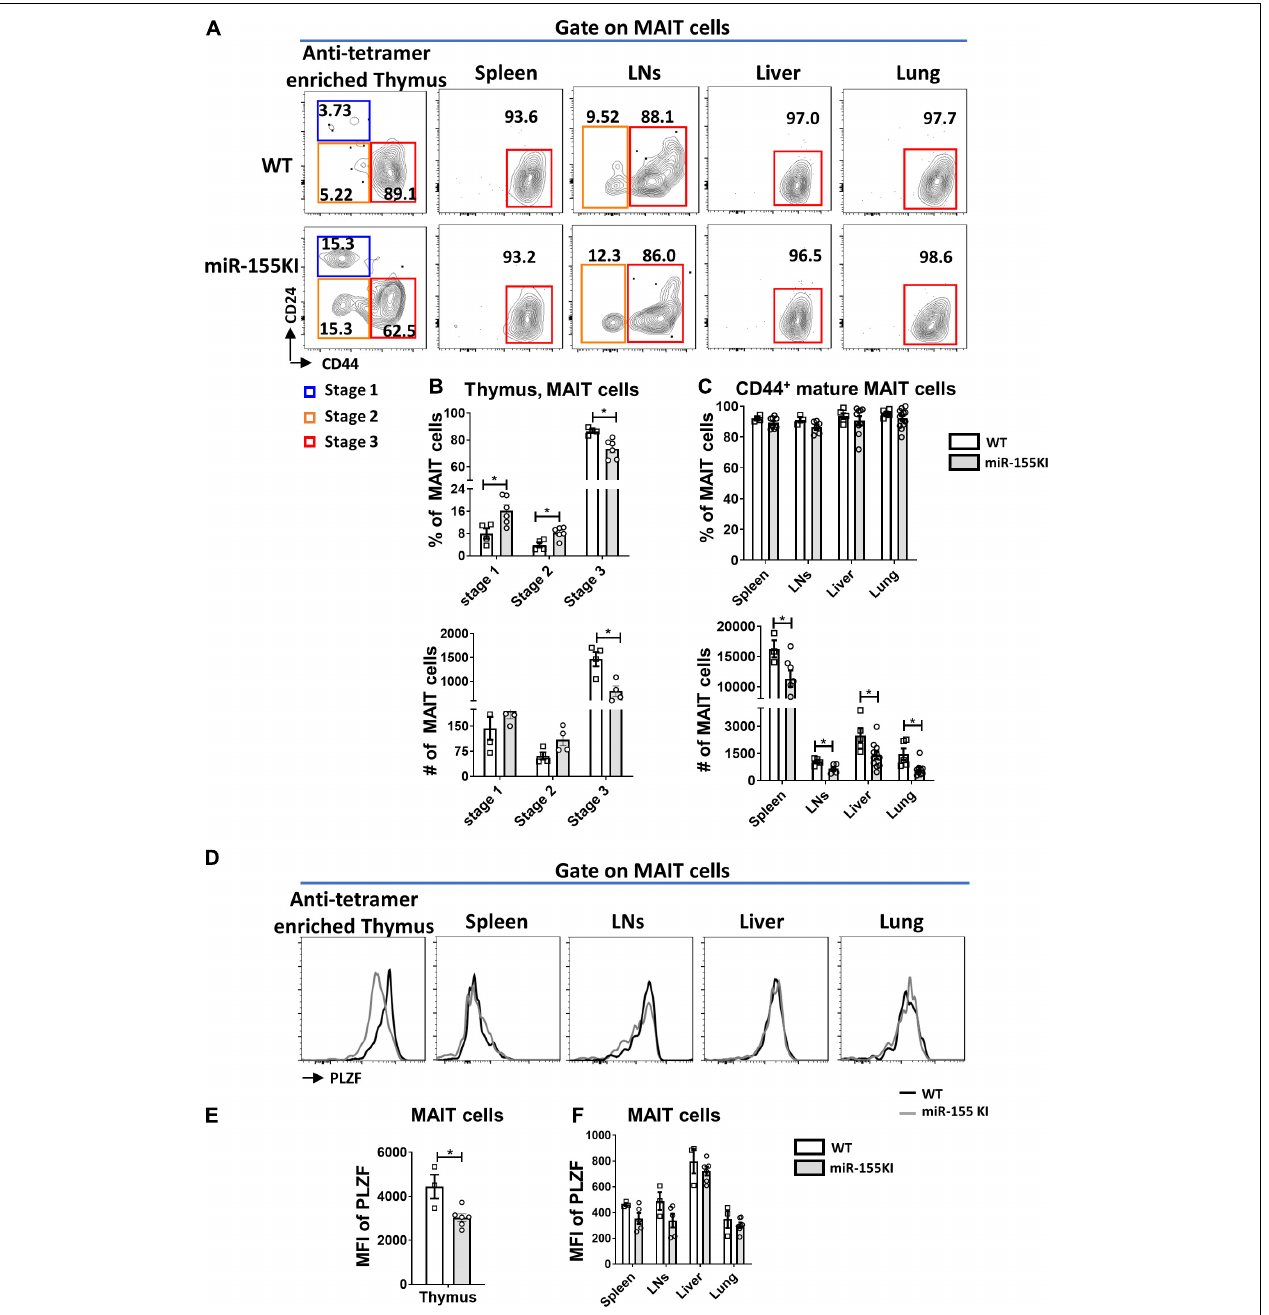
FIGURE 2 | Role of miR-155 in MAIT cell maturation. (A) The developmental stages of thymic and peripheral MAIT cells were assessed by staining the surface expression of CD24 and CD44 gated on MAIT cells. (B) Frequency and absolute number of enriched thymic MAIT cells at each stage of development and (C) frequency and absolute number of CD44 + mature MAIT cells in peripheral organs. (D) Histograms showing PLZF expression by gated MAIT cells in indicated organs of WT (black outline) and miR-155 KI (gray) mice. (E) Expression of PLZF in thymic and (F) peripheral MAIT cells. Data are from two independent experiments. Each mouse is represented as one dot. 3–8 mice for each group. Data were analyzed by unpaired t -test. * p < 0.05 compared to WT.